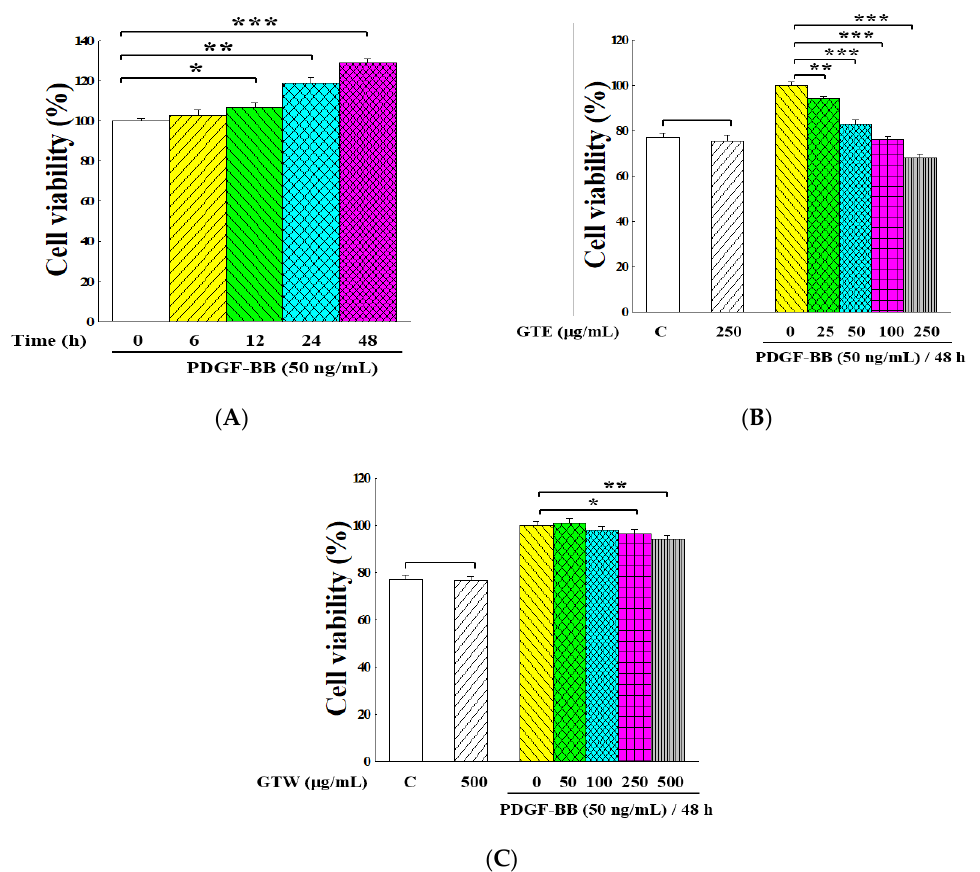
Figure 1. Inhibitory effects of Glossogyne tenuifolia ethanol extract (GTE) and Glossogyne tenuifolia water extract (GTW) on the proliferation of platelet-derived growth factor (PDGF)-BB-stimulated vascular smooth muscle cells (VSMCs). ( A ) Effect of the treatment time on the proliferation of VSMCs under the stimulation of 50 ng/mL PDGF-BB. ( B ) Effect of the GTE concentration on the proliferation of VSMCs stimulated with 50 ng/mL of PDGF-BB for 48 h. ( C ) Effect of the GTW concentration on the proliferation of VSMCs stimulated with 50 ng/mL of PDGF-BB for 48 h. The cell viability was measured by an MTT assay kit, and the number of cells was regarded as 100% with PDGF-BB stimulation and without sample treatment. Group C was the VSMC growth without PDGF-BB stimulation and GT extract treatment. Data were estimated from five replicate experiments. Significant di ff erences compared with the vehicle (group 0) are denoted as * p < 0.05, ** p < 0.01, and *** p <